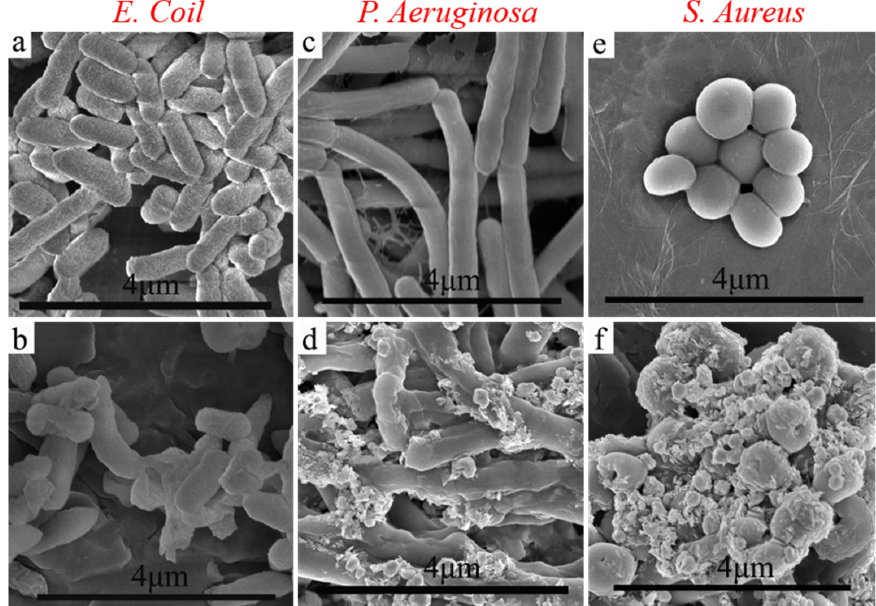
Figure 7. SEM images of the normal and treated bacteria with CuO@Ag solution (100 μ g/mL) for E. coli ( a , b ), P. aeruginosa ( c , d ), and S. aureus ( e , f